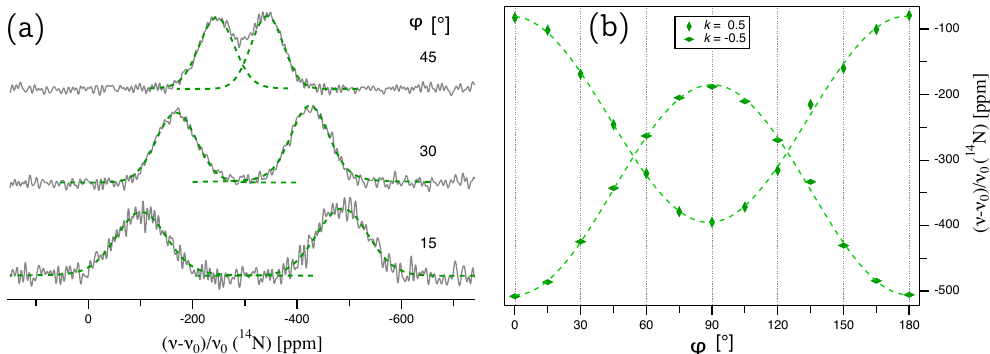
Figure 4. (a) 14 N-NMR spectra of a single crystal of aluminium nitride, AlN, rotated counter-clockwise by Figure 4. ( a ) 14 N NMR spectra of an AlN single crystal, acquired under the same conditions as listed the indicated angle j around a rotation axis perpendicular to the external magnetic field ~ B 0 and situated in the caption of Figure 2. The green, dashed lines show the deconvolution of each signal with a Voigt in the crystallographic ab plane of AlN. The gree, dashed lines show the deconvolution of each signal with profile, the maxima of which give the line positions plotted on the right. ( b ) Full 180 o rotation pattern a Voigt function. (a) Full rotation pattern over 180 o for 14 N at Wyckoff position 2 b , acquired by rotating for 14 N at Wyckoff position 2 b in AlN crystal. The point ϕ = 0 deviates by ϕ ∆ = the AlN crystal step-wise by 15 o around a rotation axis perpendicular to the external magnetic field ~ B 0 position where (cid:126) b 0 is parallel to the [000-1] direction (see text for and situated in the crystallographic ab plane. The zero point of the rotation, j = 0 , is defined by ~ B 0 being almost parallel to the [0001] direction, with the actual crystal orientation deviating by j D = it (see text for details). The plotted line positions were taken from a Voigt fit of each 14 N NMR signal. For the determination of the quadrupole coupling tensor Q N and the chemical shift tensor d N 136 of 14 N in aluminum nitride, the same AlN crystal (Figure. 1a) and goniometer axis as for 27 Al was 137 used. Only the offset angle j D is different and initially unknown due to a change of the solenoid coil 138 of the NMR probe after all 27 Al spectra were recorded. Representative 14 N NMR spectra are shown in 139